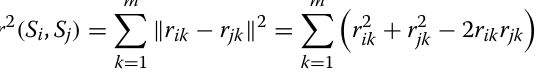
determination. The determination error for the traditional method mainly comes from the missing detection after the mode switching. This is because it cannot recognize the mode switching, and thus the acceleration after the switching is misjudged as a glitch and be filtered. But the proposed method can successfully avoid the above-mentioned prob-